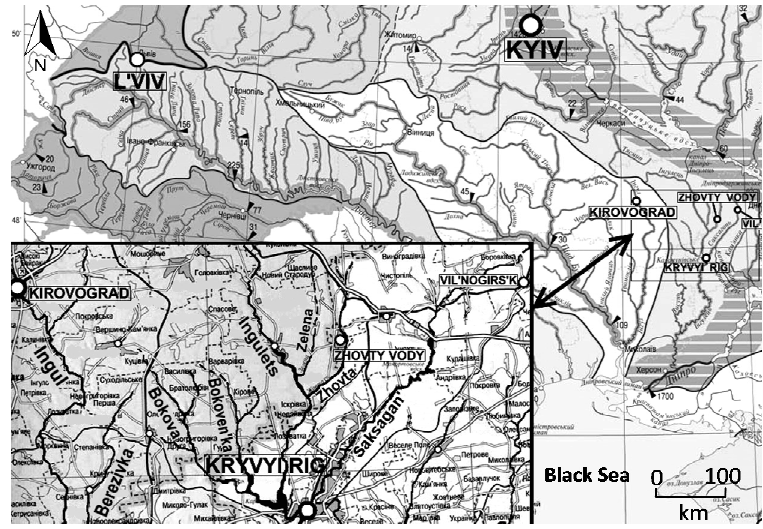
Figure 1. Kryvyi Rig Basin location.